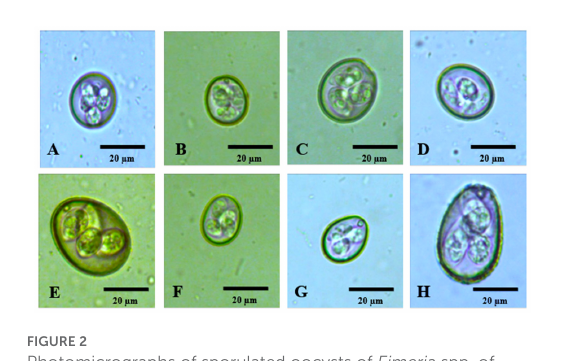
FIGURE2 Photomicrographs of sporulated oocysts of Eimeria spp. of free-range chickens in the state of Paraíba, northeastern Brazil. (A) Eimeria necatrix ; (B) Eimeria mitis ; (C) Eimeria mivati ; (D) Eimeria tenella ; (E) Eimeria brunetti ; (F) Eimeria acervulina ; (G) Eimeria praecox ; (H) Eimeria maxima . Magnification of 400 ×